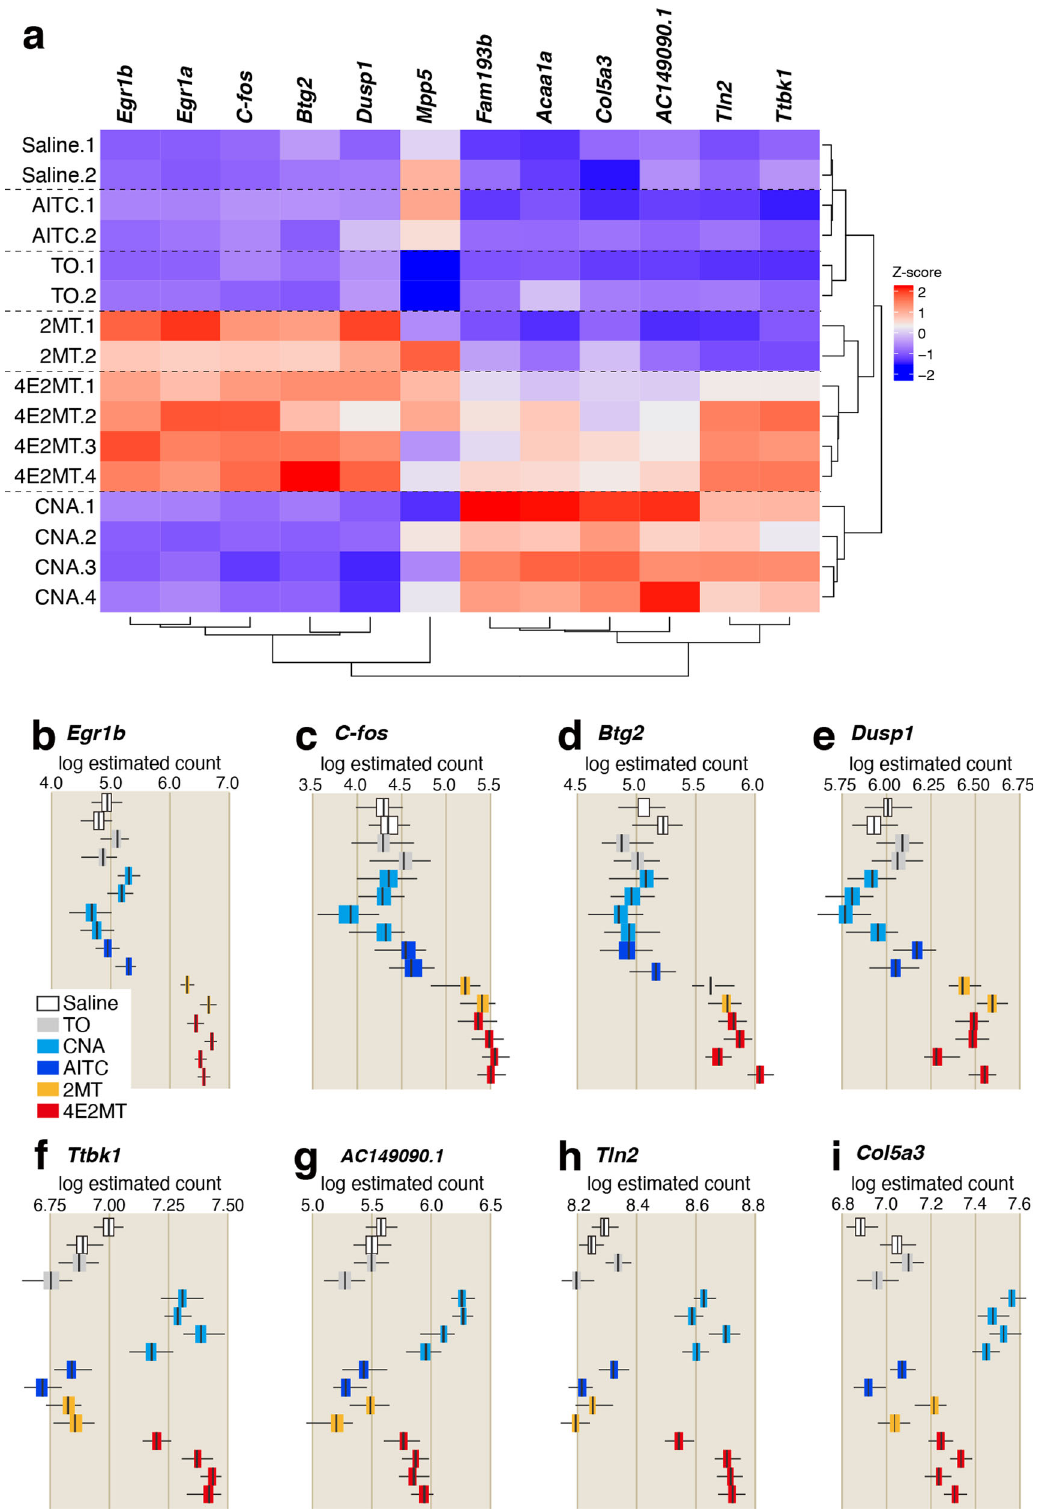
Fig. 9 Compounds induce differential gene expression in the TG. a Clustered heat map depicting relationships across 12 genes, which exhibited signi fi cant differences ( q < 0.01) under 16 stimulation conditions. The color bar indicates the z score scale. Egr1a and Egr1b are Ensemble transcript ENSMUST0000006479.5 and ENSMUST00000165033.1, respectively. b – i Box plots depicting the log estimated counts of gene expression in 16 stimulation conditions are shown for the indicated genes that exhibited signi fi cant differences ( q < 0.01); n = 2 for saline, TO, AITC, and 2MT, and n = 4 for CNA and 4E2M; q = 0.00024 for Egr1b ( b ), q = 0.0012 for c-fos ( c ), q = 0.0024 for Btg2 ( d ), q = 0.0067 for Dusp1 ( e ), q = 0.0047 for Tbk1 ( f ), q = 0.0045 for AC149090.1 ( g ), q = 0.0058 for Tln2 ( h ), and q = 0.0083 for Col5a3 ( i ). All boxplots indicate median (center line), 25th and 75th percentiles (bounds of box), and minimum and maximum (whiskers); q value obtained by likelihood ratio test was corrected by Benjamin – Hochberg multiple test.